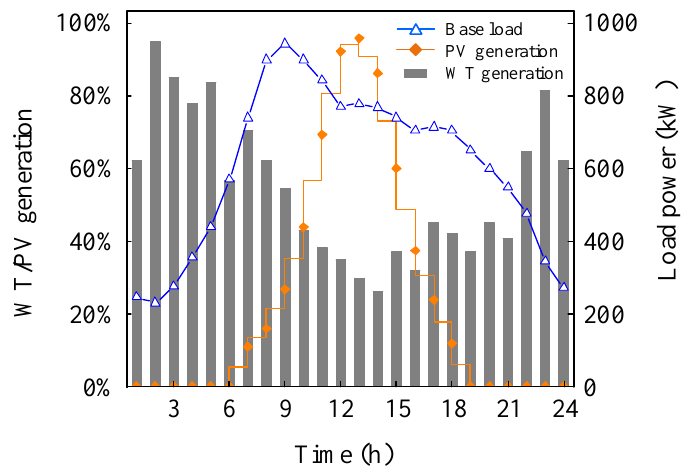
Figure 3. Typical forecasted wind and photovoltaic generation profile and load curve.